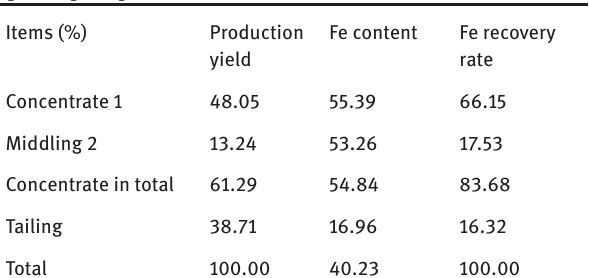
SP-52-B, roasting temperature 800 o C, 11% WG coal, 20 min grinding, magnetic field: 1.5A